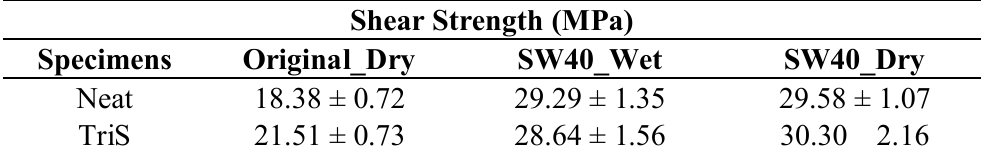
Table 4. Comparison of interlaminar shear strength after environmental